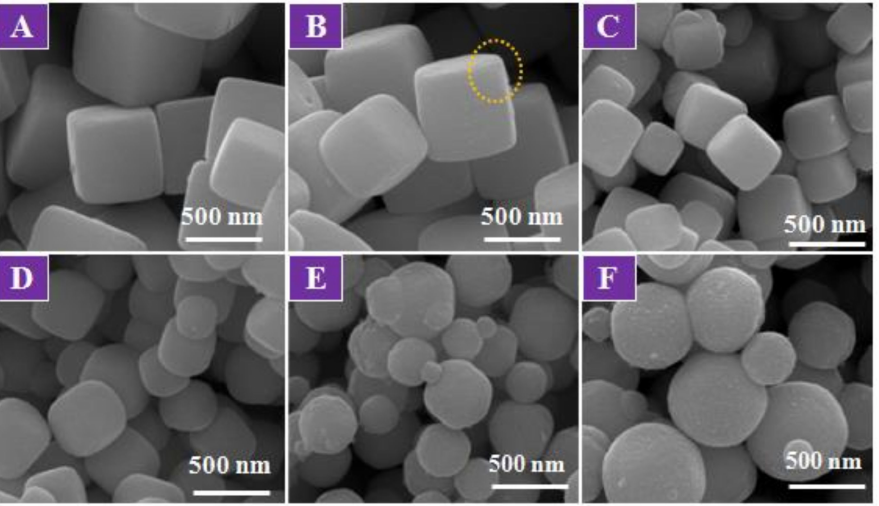
Figure 2. SEM images of the as-prepared samples: ( A ) c-Cu 2 O(100), ( B ) Cu 2 O-0.5, ( C ) Cu 2 O-1,